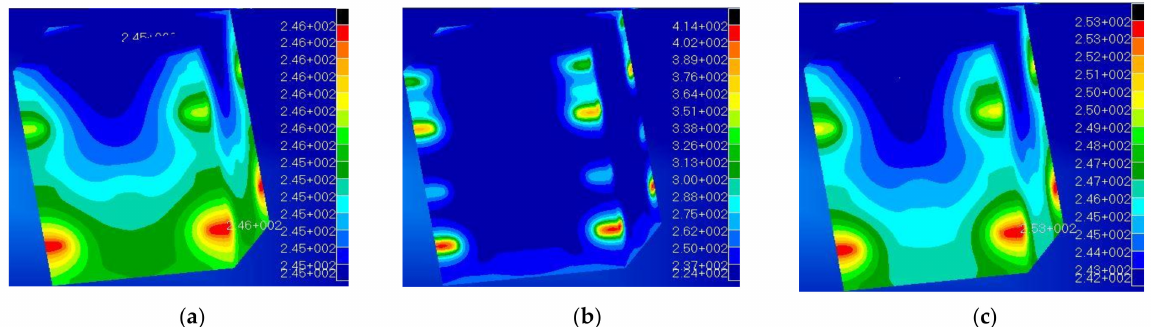
Figure 6. ( a ) Contour of temperature with aluminum (K = 170 W/mK); ( b ) contour of temperature with PEEK (K = 0.2 W/mK); ( c ) identified requested threshold value K = 5 W/mK to reach satisfactory heat